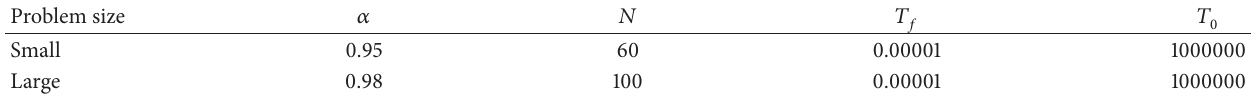
Table 7: Tuned values of the simulated annealing